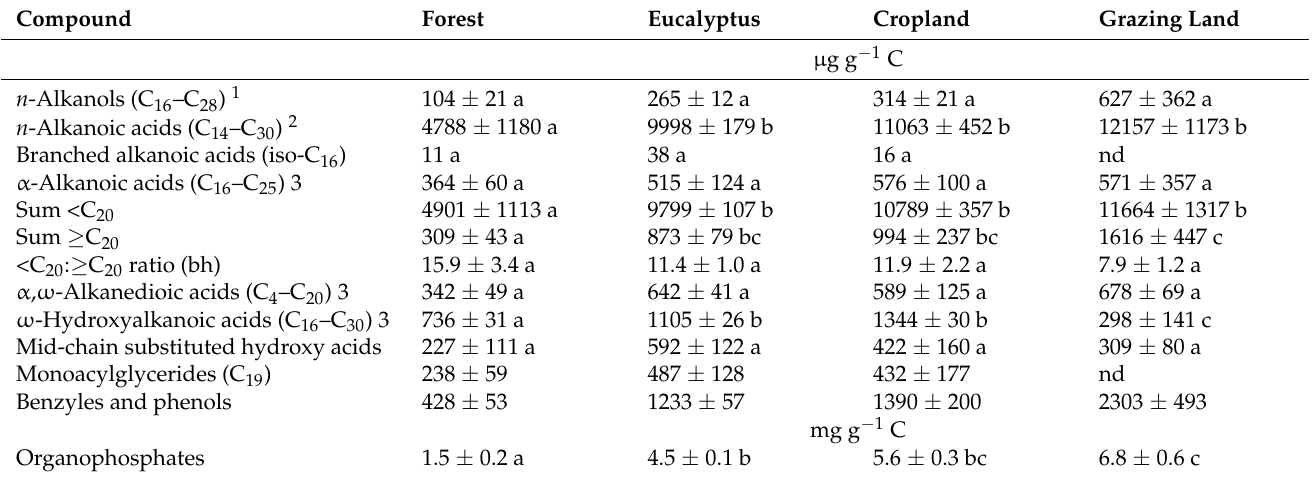
Table 3. Compounds, their sums, and their ratios, as identified from base hydrolysis (bh) of soil samples in different land-use systems in Gelawdios, Ethiopia (mean ± SE, n = 3). All values are in µ g g − 1 C or mg g − 1 C, as shown. Different letters indicate a significant difference between land-uses ( p ≤